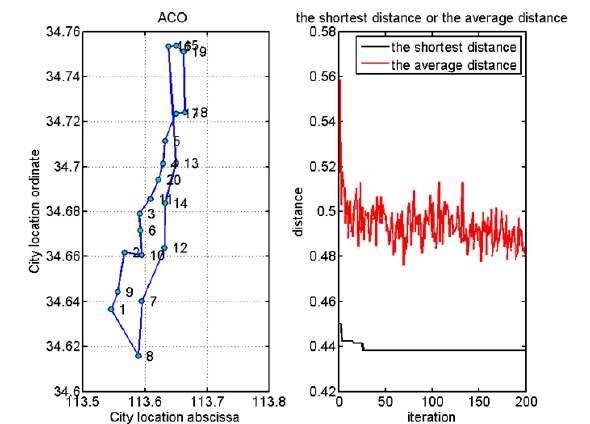
Figure 4. Denotes the optimal route of urban-rural bus The TSP problem.